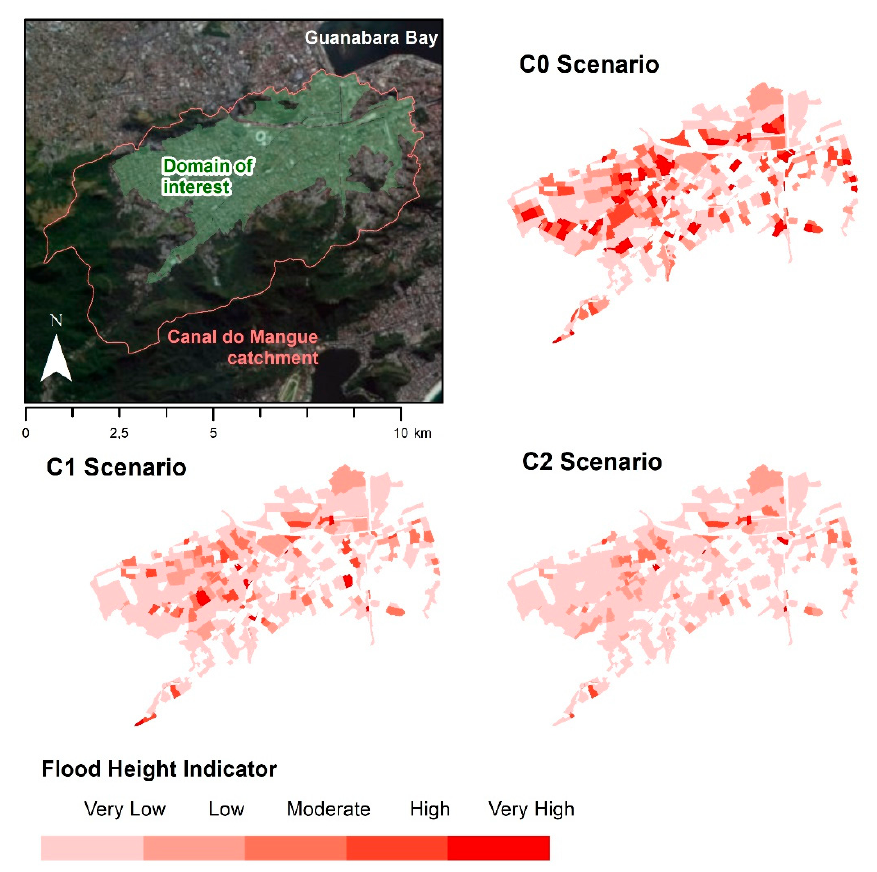
Figure 10. Flood Height indicator (I h ) for a 25-year event: (C0) without interventions, (C1) with concentrated measures and (C2) with distributed interventions.